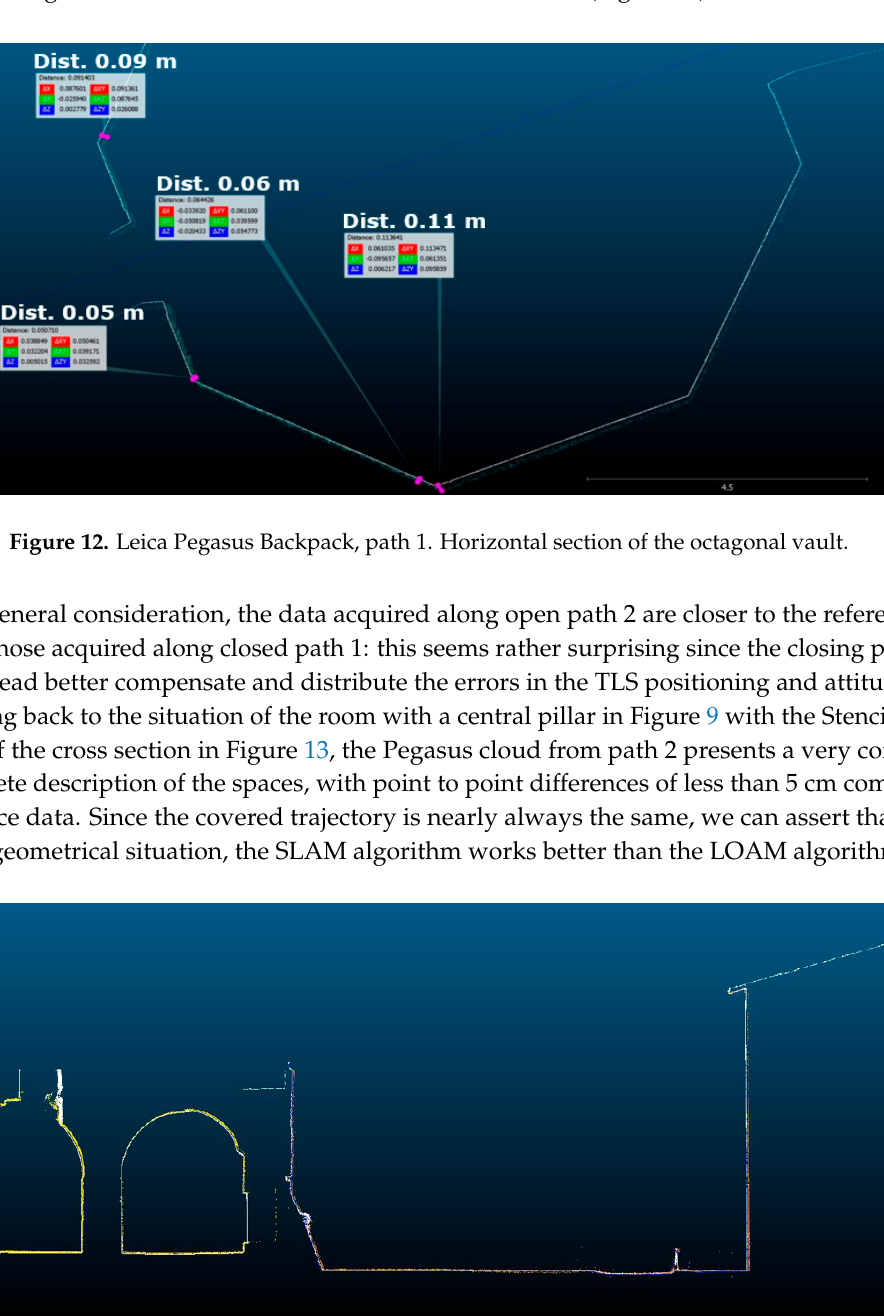
Figure 13. Leica Pegasus, path 2. Cross Section 1 (reference data in white, compared dataset in colour).